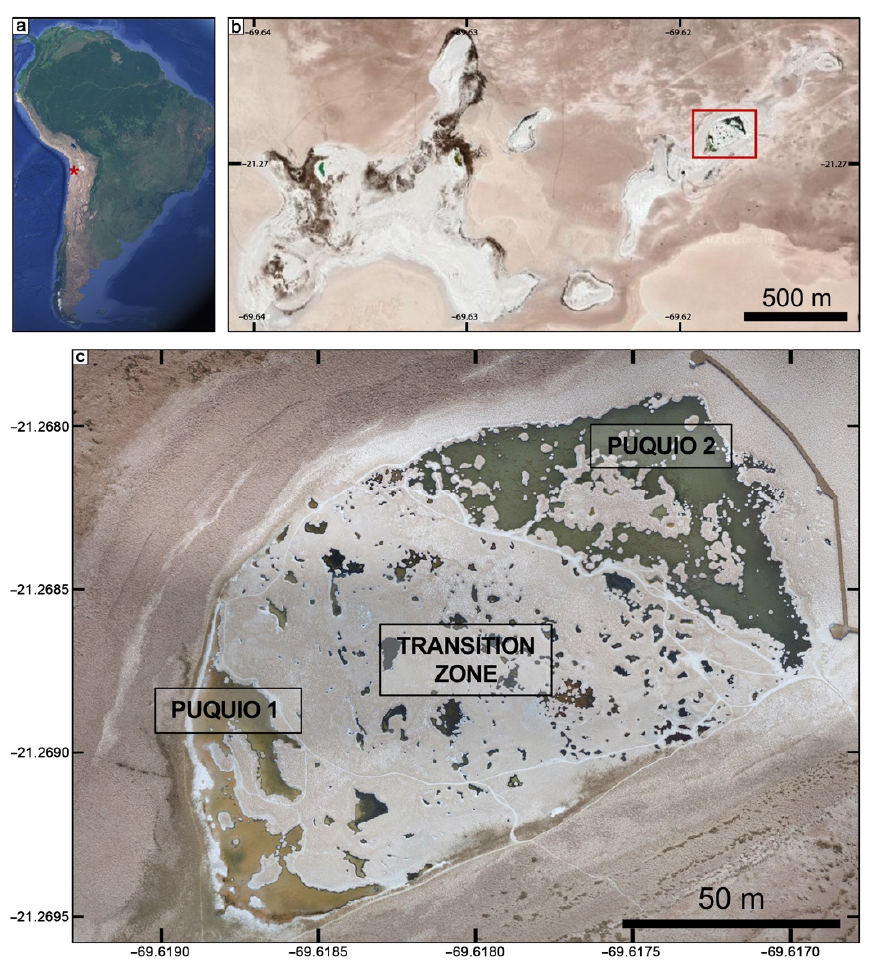
Figure 1. Location map: ( a ) regional context and location of the Salar de Llamara, northern Chile; ( b ) Puquios system within the Salar de Llamara with the red box highlighting ( c ) Puquio 1, Puquio 2, and the Transition Zone.